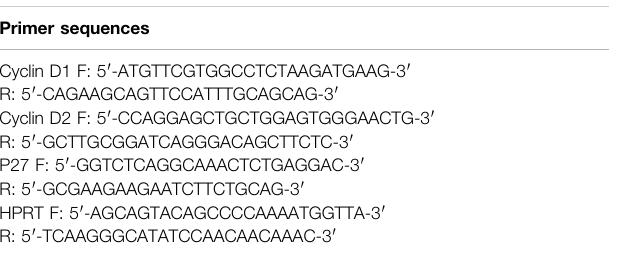
TABLE 1 | Primer sequences for